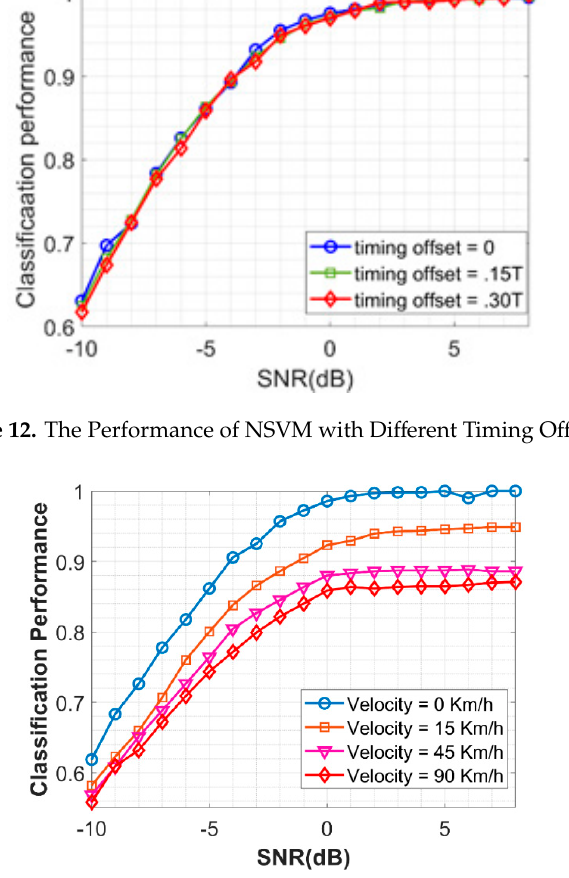
Table 4. Comparison with other works.